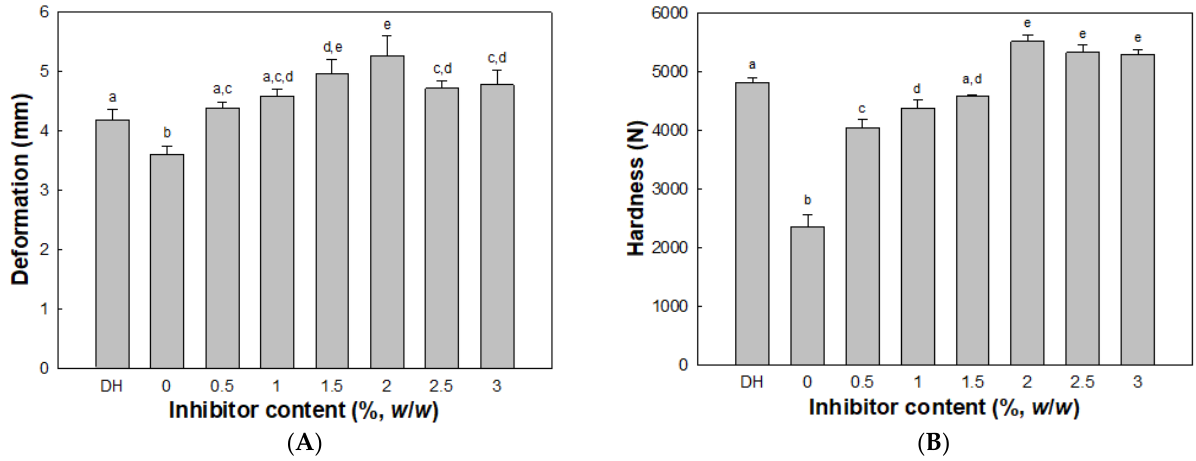
Figure 5. Deformation ( A ) and hardness ( B ) of surimi gels with inhibitor. Different letters indicate significant differences ( p < 0.05). Directly heated (DH) gel without inhibitor.